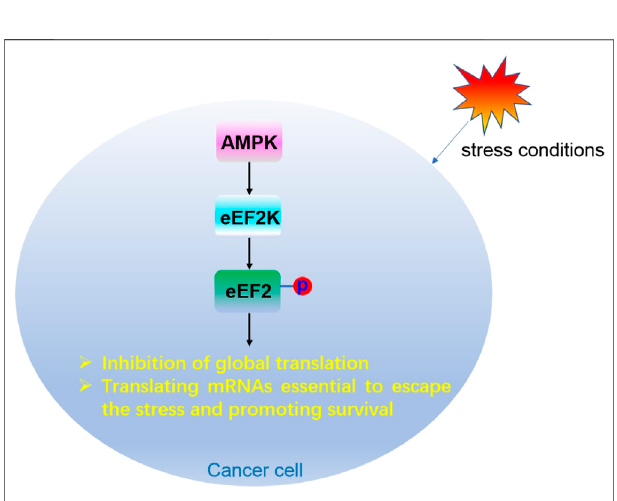
FIGURE 8 | Regulation mechanism of eEF2 phosphorylation modi fi cation in cancer